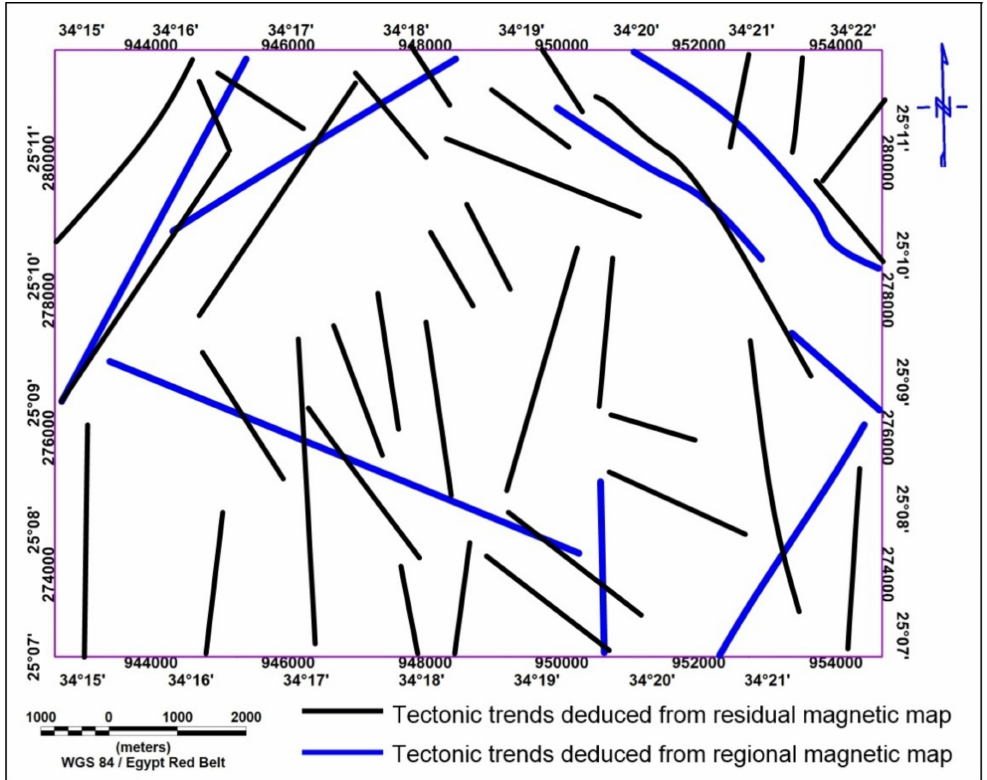
Figure 13. Lineaments as deduced from the regional and residual aeromagnetic map of Homrit Waggat area, Central Eastern Desert,